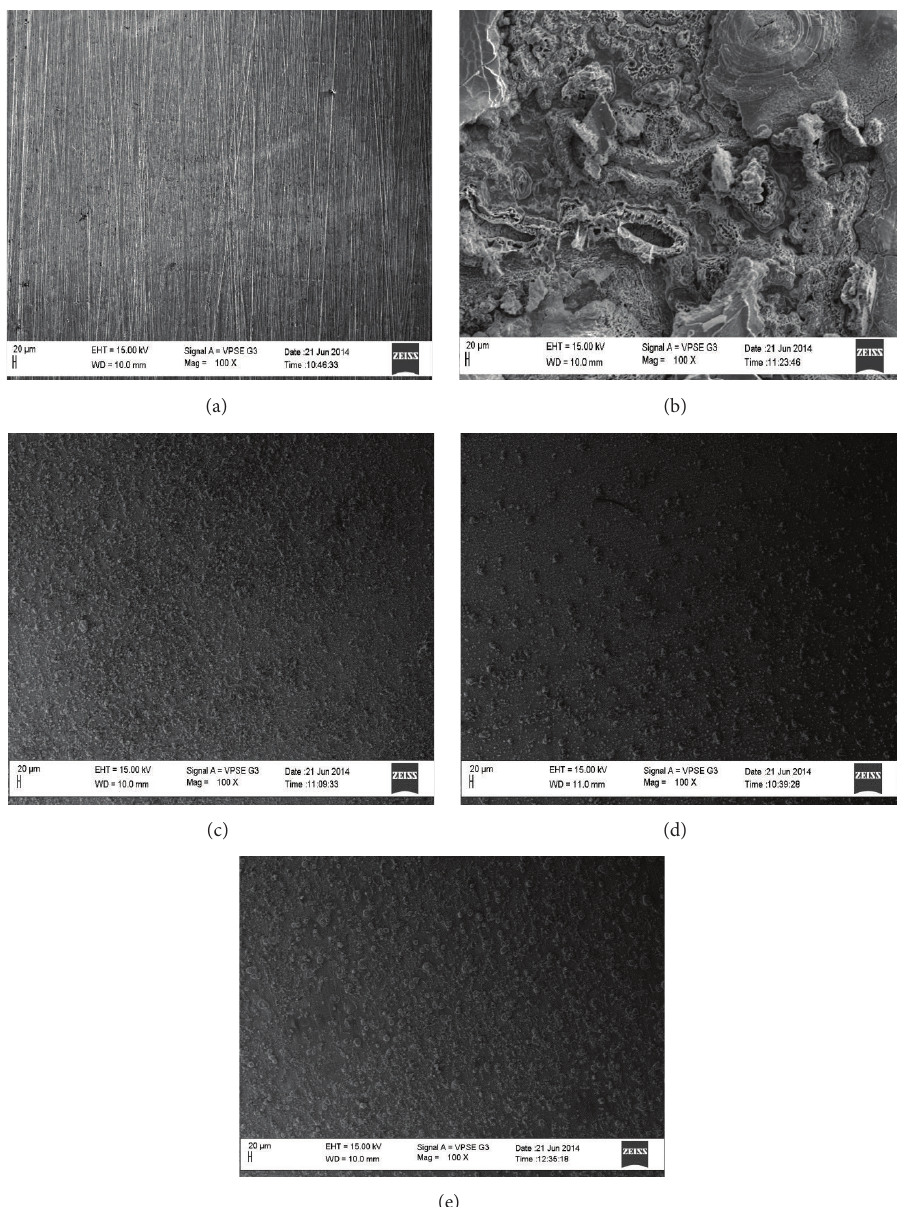
Figure 10: SEM images of MS surface (a) polished, (b) immersed in 0.5 M HCl, (c) immersed in 0.5 M HCl in the presence of 2-MTPH, (d) immersed in 0.5 M HCl in the presence of 3-MTPH, and (e) immersed in 0.5 M HCl in the presence of